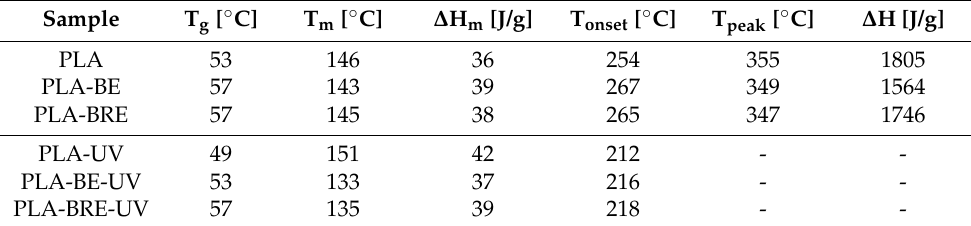
Table 1. DSC data for the neat PLA and PLA composites with bentonite and AO before and after the UV ageing test.